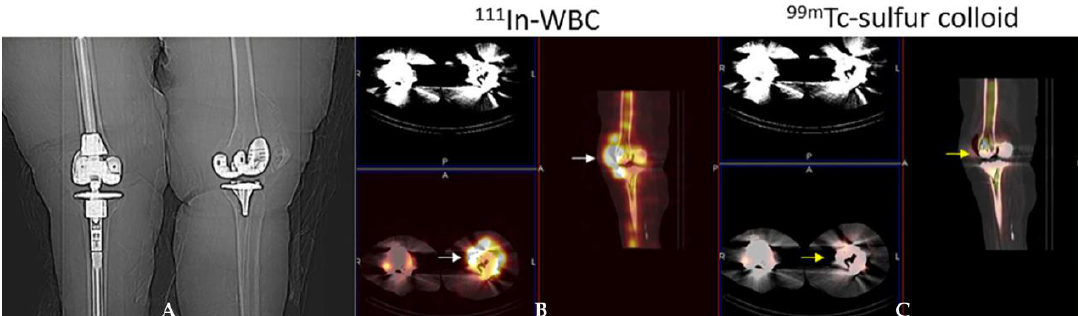
Figure 4. Periprosthetic infection left knee arthroplasty. Scout radiograph ( A ) demonstrates bilateral knee arthroplasties. The right is a revision arthroplasty and the left is a primary implant. On the 111 In-WBC single photon emission computed tomography/computed tomography (SPECT)/CT) ( B ) there is abnormal labeled leukocyte activity along the anterior aspect of the left knee arthroplasty (white arrows). On the 99m Tc-sulfur colloid SPECT/CT ( C ), there is no corresponding activity in this region (yellow arrows) and therefore the study is positive for infection.